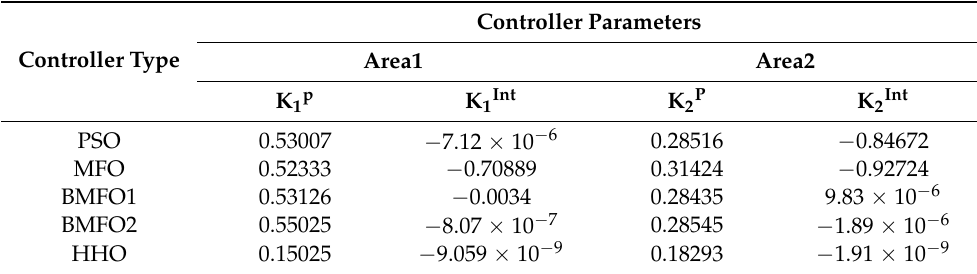
Table 2. Improved gain values of Proportional Integral (PI) controller for the expected scheme with various